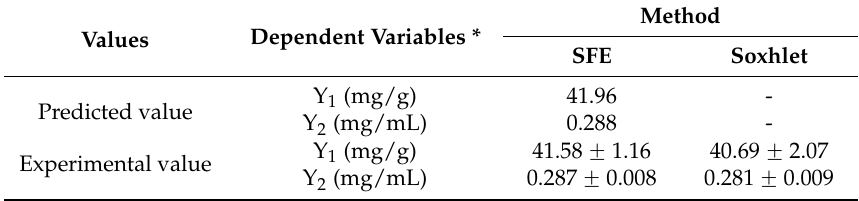
Table 3. Comparison of the dependent variables obtained by SFE and Soxhlet extraction.